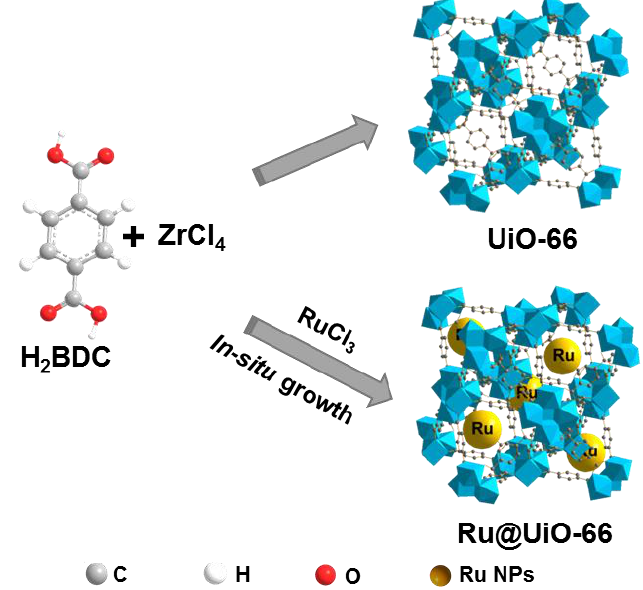
Figure 1. Schematic illustration for the synthesis of UiO-66 and Ru@UiO-66.